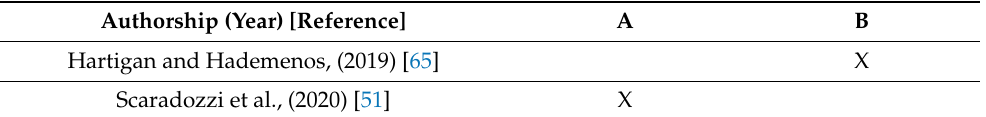
Table 5. Classification of the papers selected by type of EDA strategy implemented: (A) k-means clustering (Elbow Method), and (B) Data Plot.